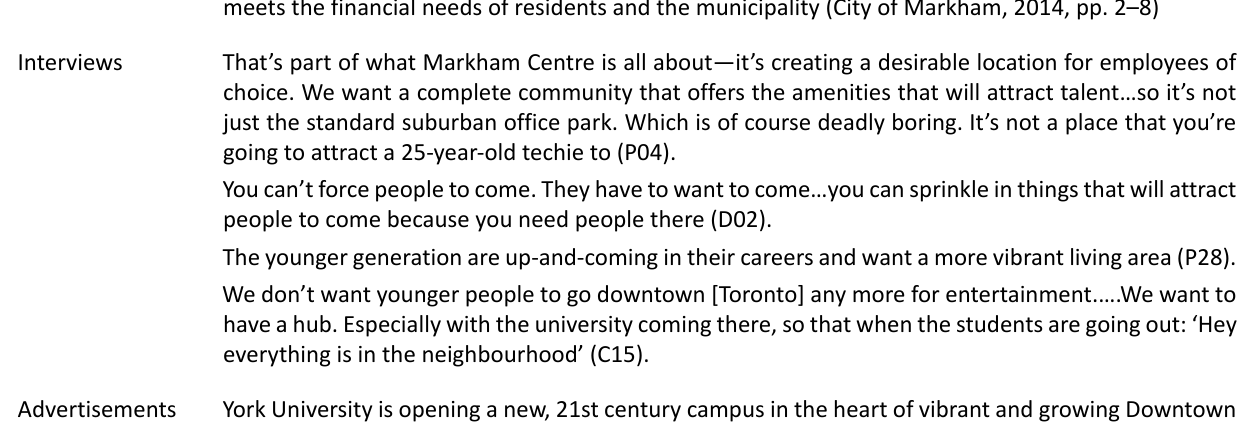
Table 1. Discourses of mixed use and attraction in policy, interviews, and advertisements.